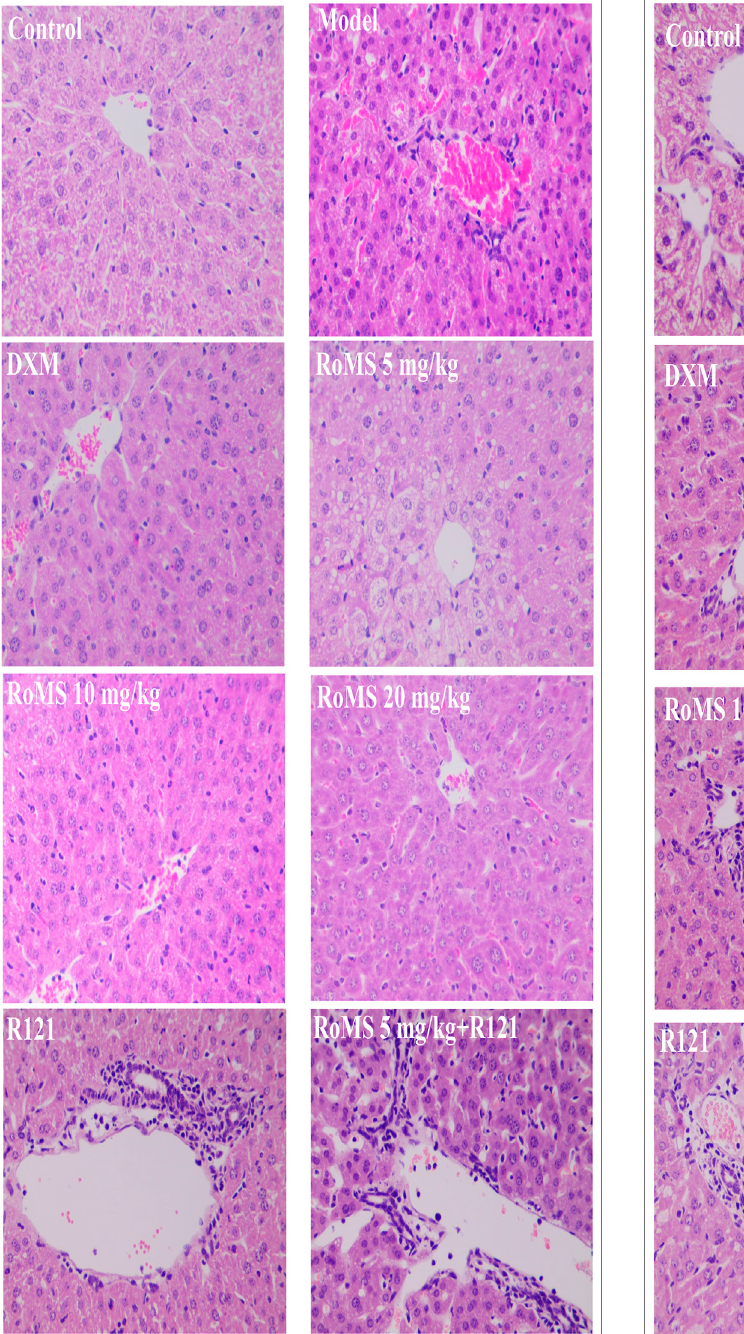
FIGURE 3 | Effect of RoMS (at 3 days after pre-administration) on liver injury in mice. Liver tissues were stained with H&E, ×400 magni fi cation.